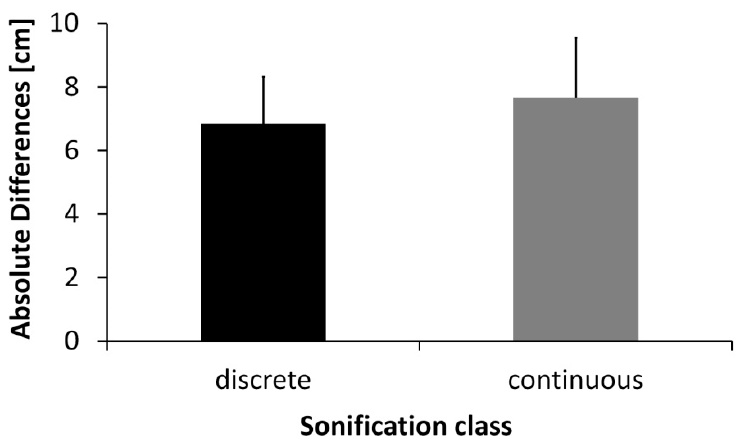
Figure 7. Means and standard deviations of absolute differences for the two sonification classes for instruction and feedback.